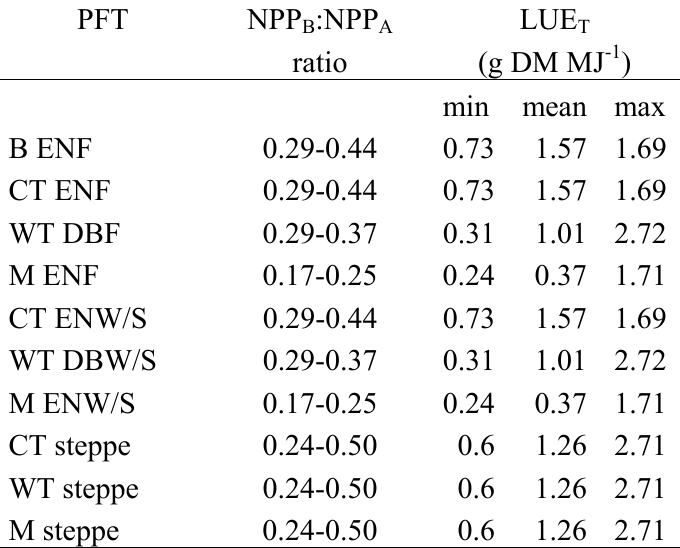
Table 1. Ranges of light use efficiency and ratios of belowground to aboveground net primary productivity (NPP) used for different plant functional types (PFTs) and biogeoclimate zones in the DECP model as modified from